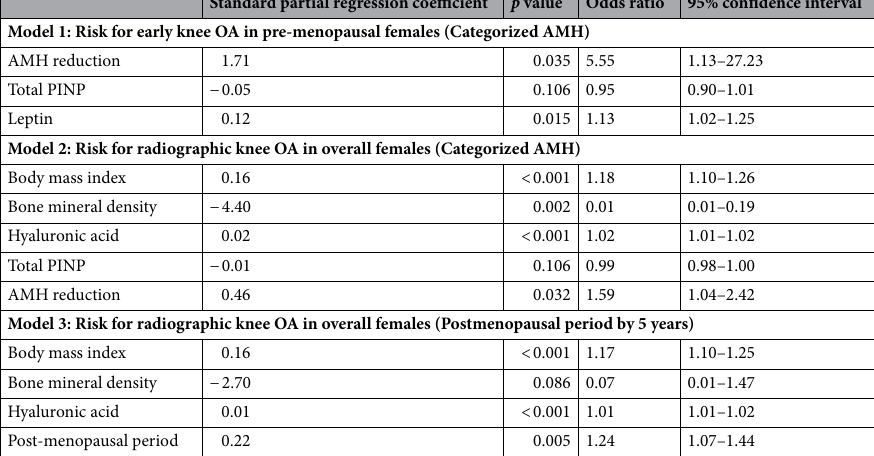
Model 2: Risk for radiographic knee OA in overall females (Categorized